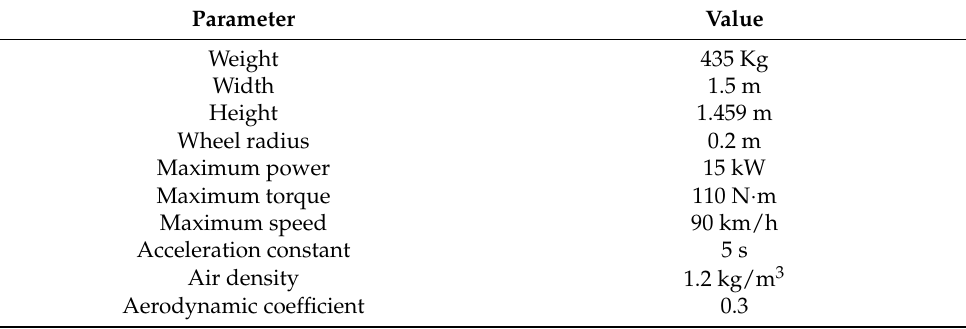
Table 3. Electric vehicle and environmental parameters. Parameter